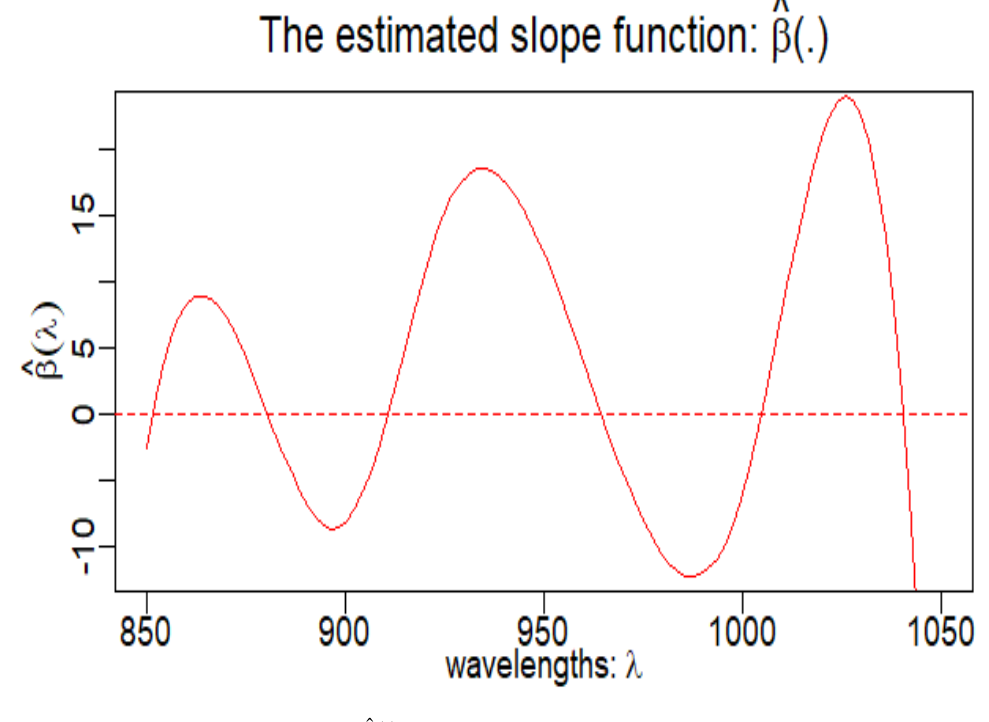
Figure 7. Estimated slope function ˆ β ( . )